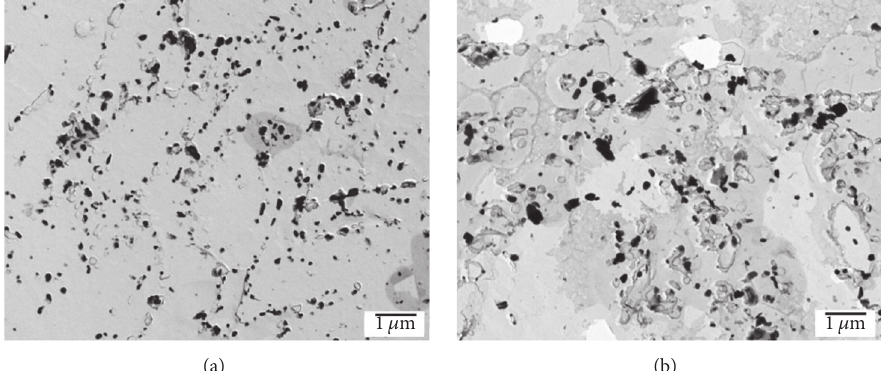
Figure 5: TEM carbon extraction replica visualization of secondary phase precipitates in BM of studied CB2 weldment in PWHT state (a) and after 30 kh ageing at 625 ∘ C